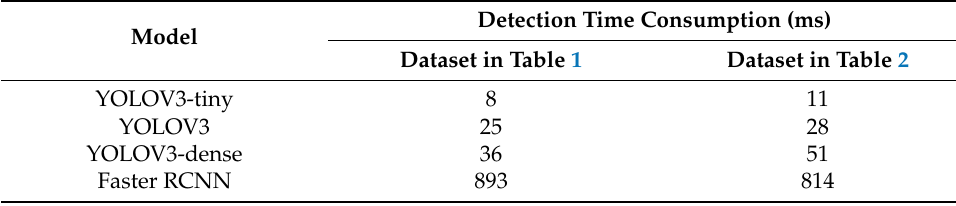
Table 6. Comparisons of real-time zooplankton detection